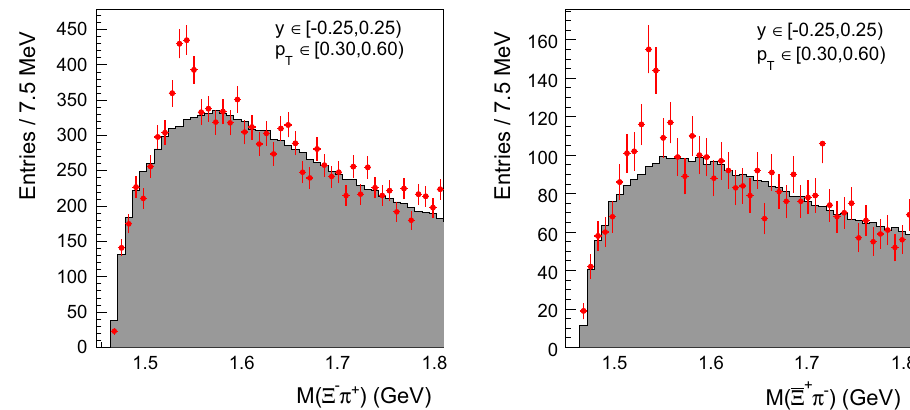
Fig. 4 Invariant mass